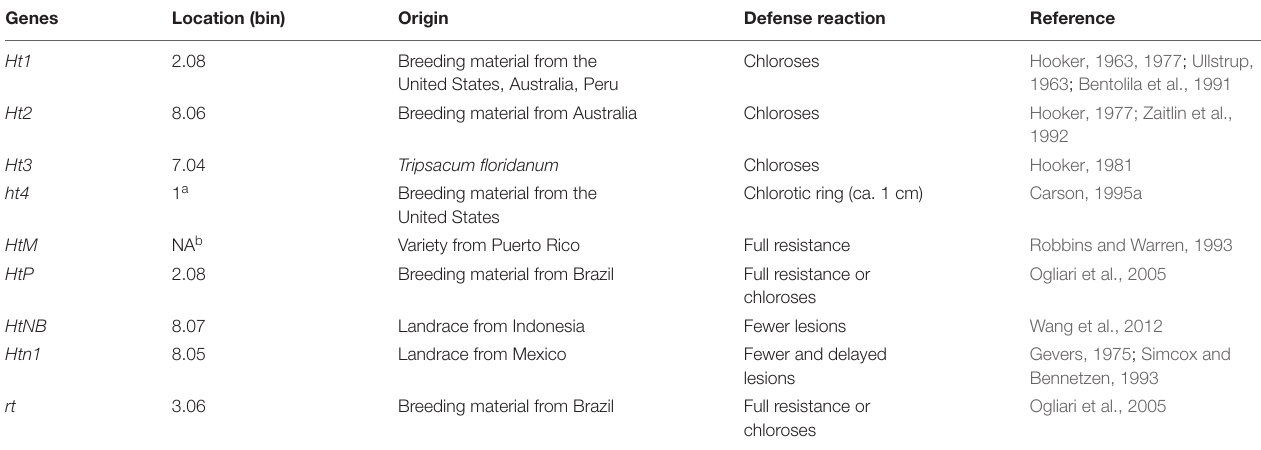
TABLE 2 | Origin of qualitative resistance genes against Setosphaeria turcica and its defense reactions.